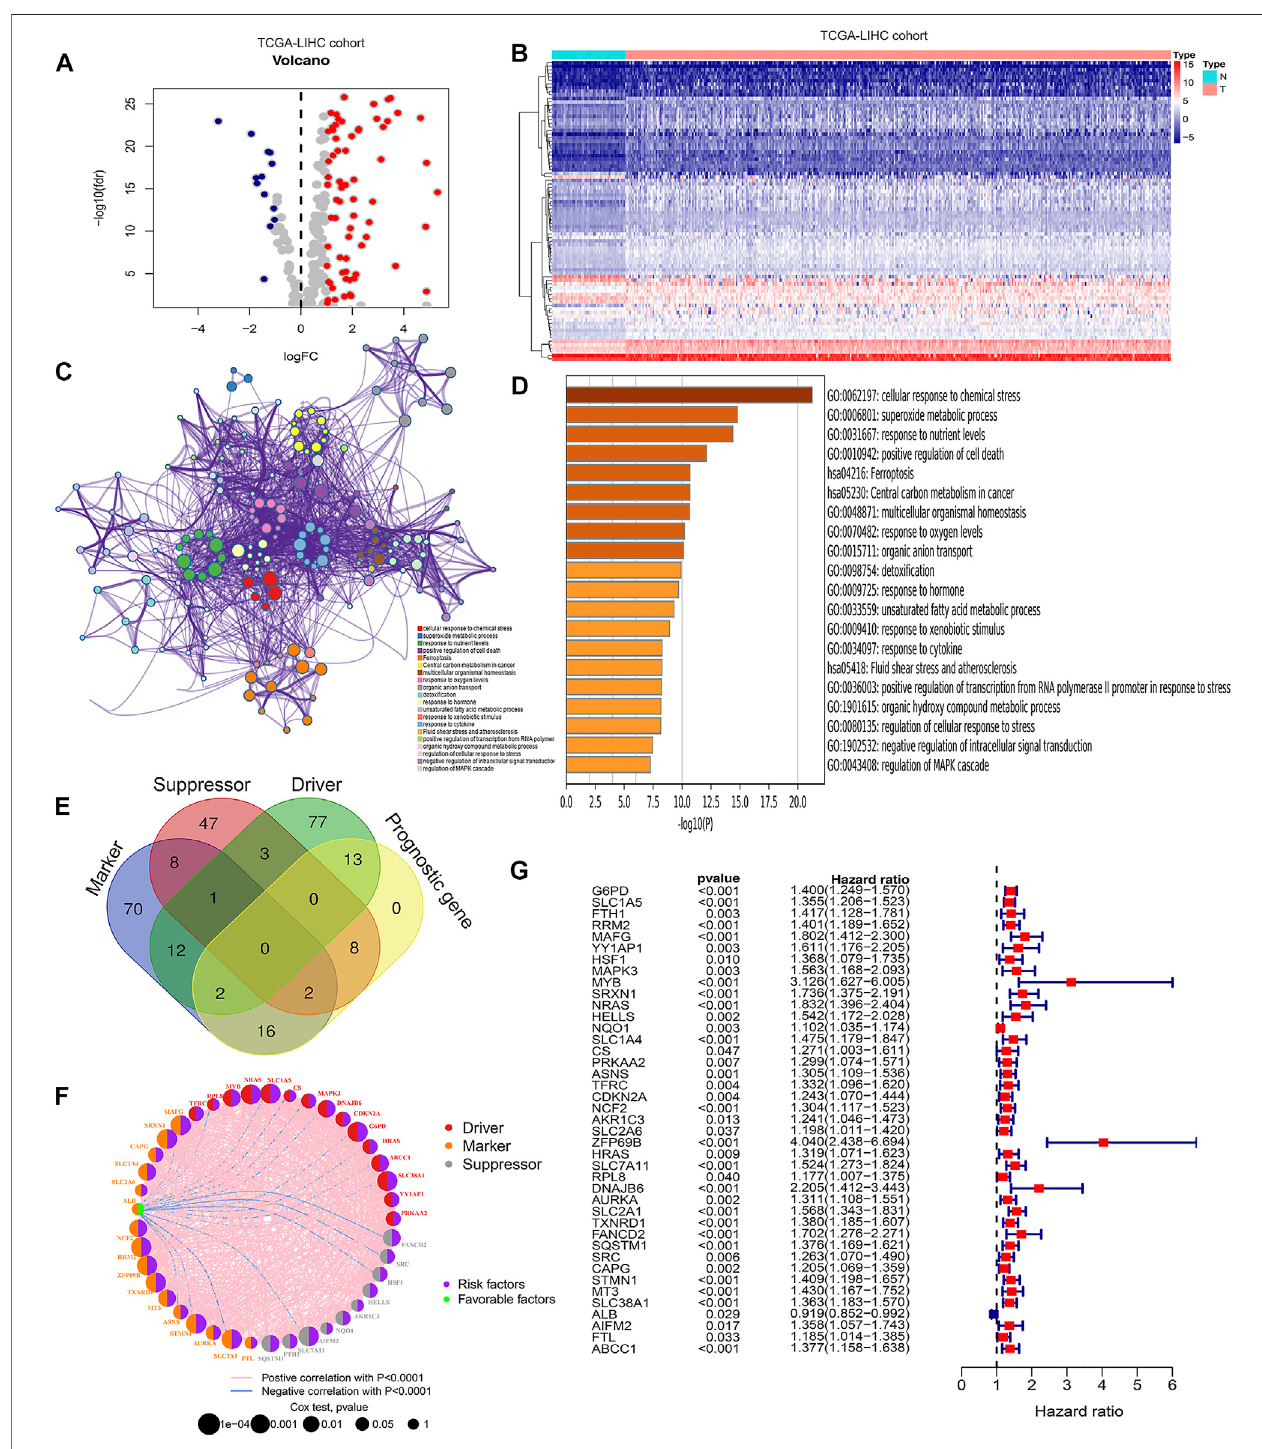
FIGURE 1 | Identi fi cation of prognostic related ferroptosis regulators in HCC. (A) Volcano plot showing the expression characteristics of differentially expressed genes (DEGs) between tumor tissues and normal tissues in the TCGA-LIHC cohort. (B) Heatmap showing DEGs associated with ferroptosis in the TCGA-LIHC cohort. (C) Protein – protein network indicating the top 20 regulatory signaling pathways of DEGs via KEGG and GO functional analyses. (D) Bar plots showing the top 20 regulatory signaling pathways of DEGs via KEGG and GO functional analyses. (E) Venn diagram showing the function of ferroptosis-related genes. (F) Protein – proteinnetworkindicatingthegenefunction,interaction,andprognosticroleofDEGs. (G) ForestplotshowingtheprognosticvalueofDEGsusingunivariateCox analysis.